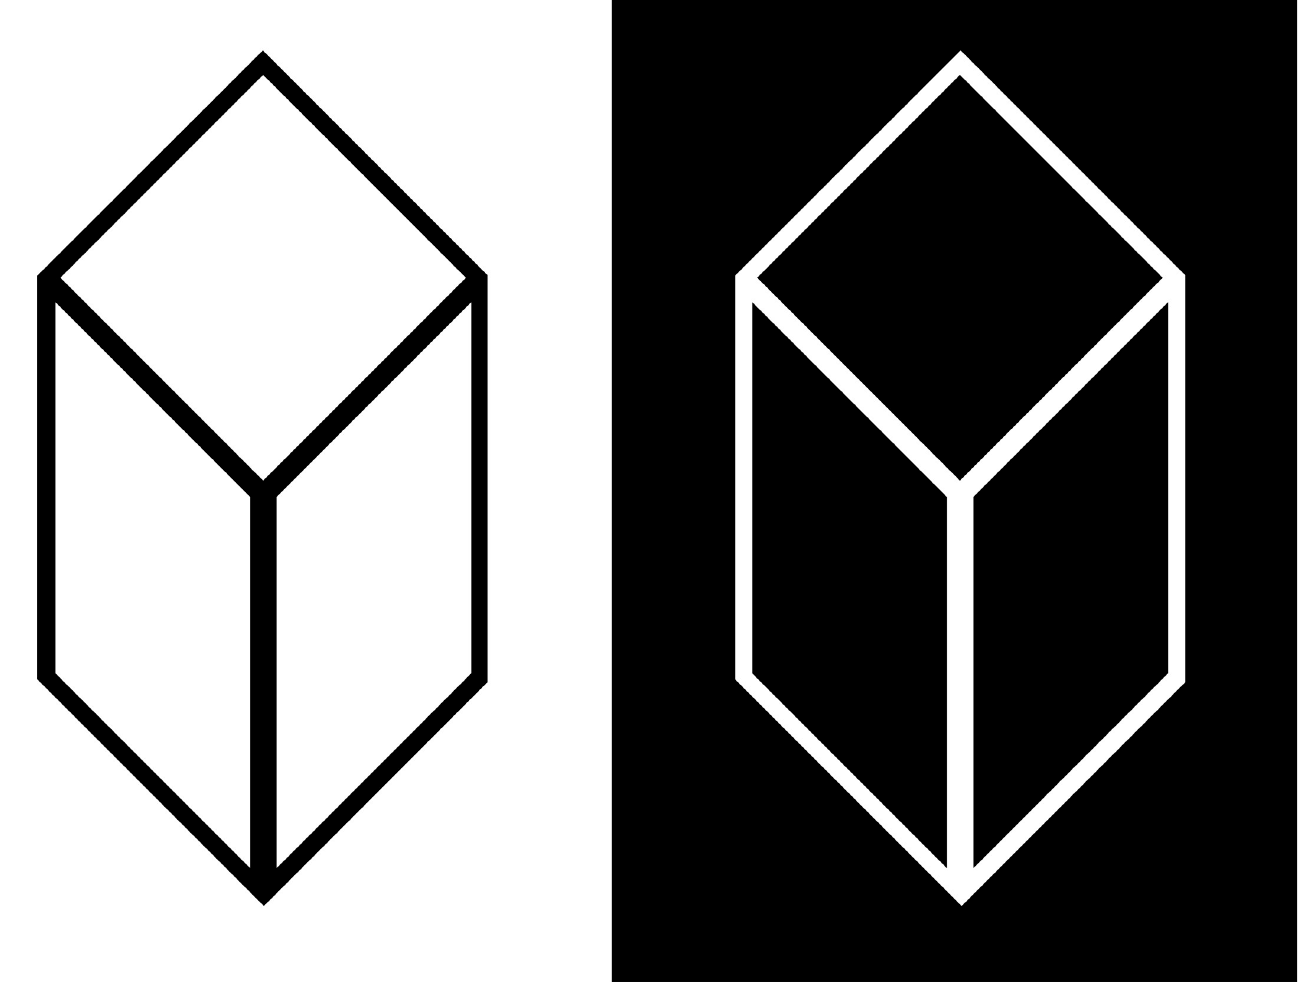
Fig 2. Binocular luster example. Stereogram of "crystal" image with maximum luminance disparity for demonstrating binocular luster, taken after the written description by Helmholtz [9, 10]. Either crossed or uncrossed fusion is appropriate. The entire fused image will shimmer.